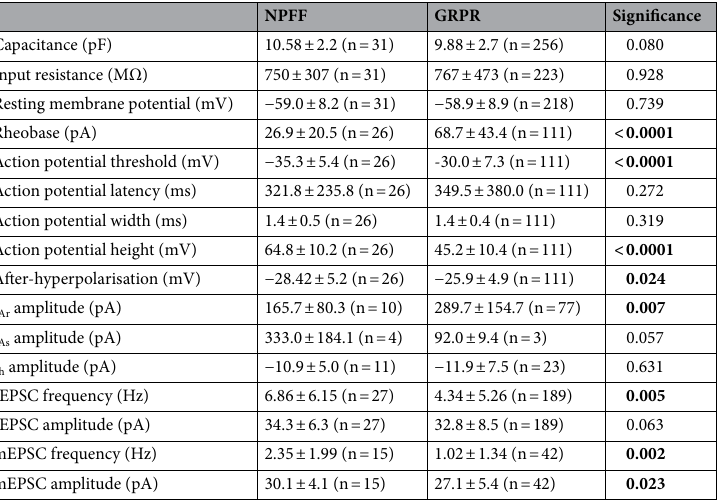
Table 1. Comparison between electrophysiological findings for NPFF and GRPR cells. Data for GRPR cells was obtained from Polgár et al 18 . Details of the statistical tests are provided in the text. Significant values are in